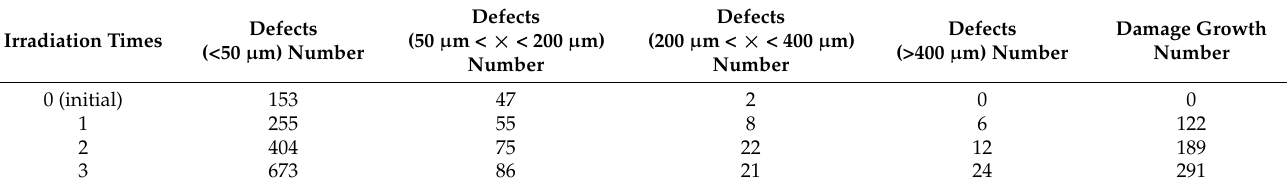
Table 2. Statistics of defects with different scales.